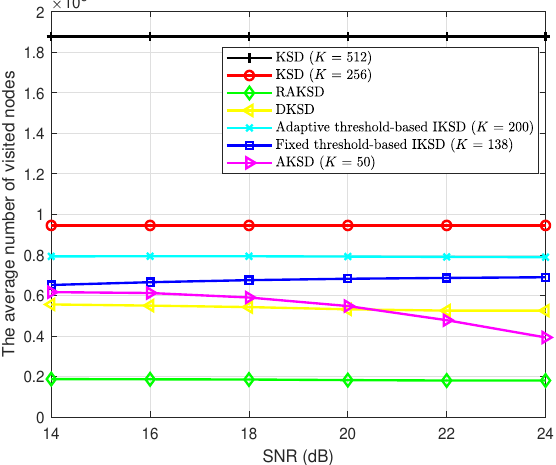
Figure 3. The complexity comparison of KSD algorithms for a 48 × 48 MIMO system with